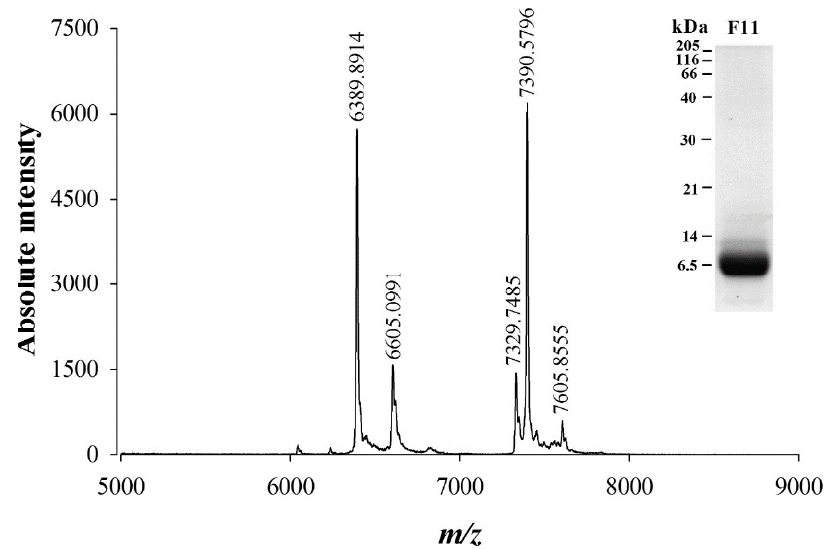
Figure 2. Mass characterization of F11 fraction components by MALDI-TOF MS and SDS-PAGE. Five ions were detected using the linear positive mode in the range of MW detected by SDS-PAGE migration and Coomassie blue staining (inset). [M + 1H] 1 + m / z values of compounds present in F11 fraction are given on top of each